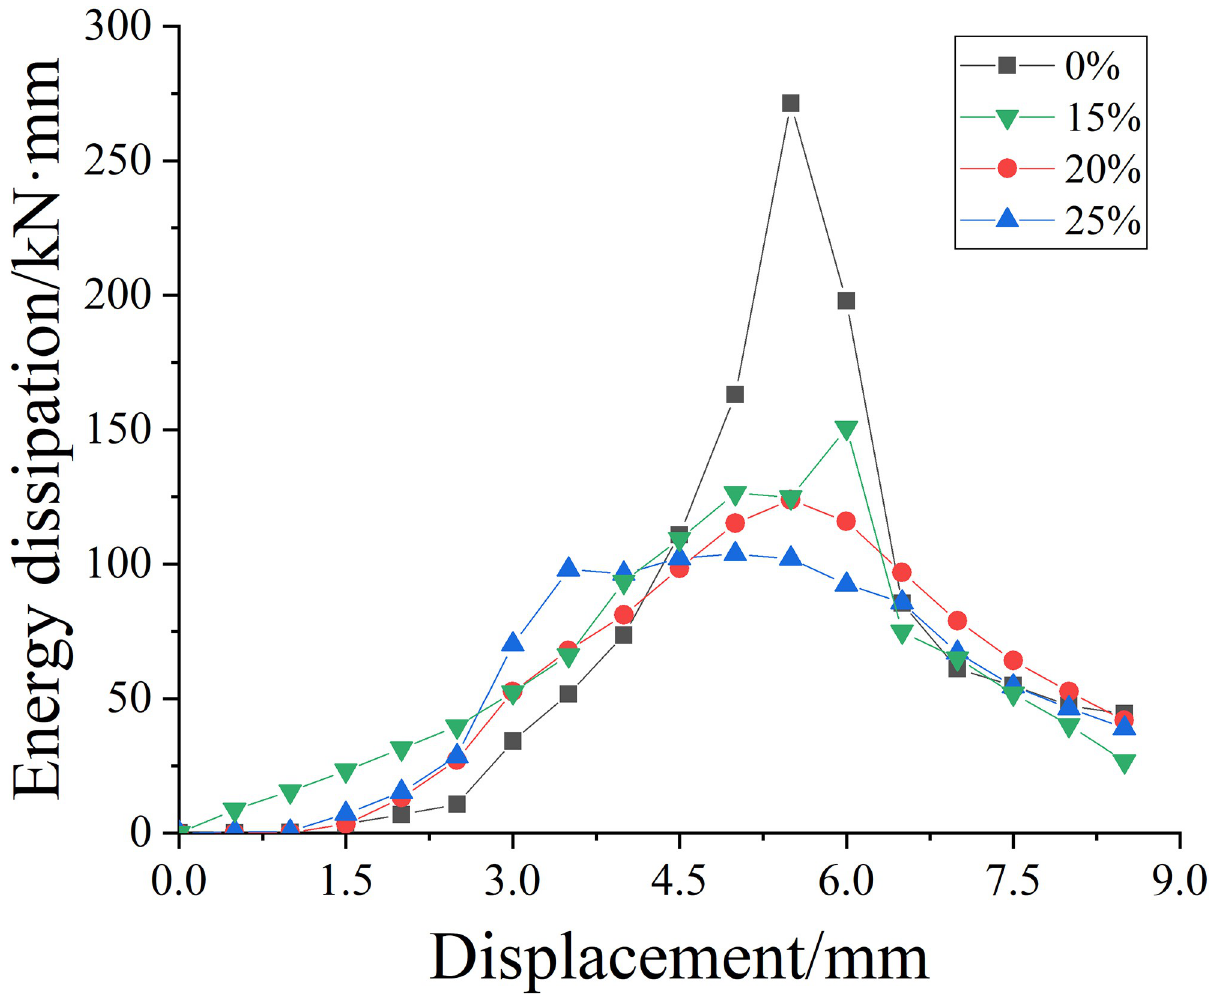
Fig 10. Energy dissipation displacement curves of specimens with different concentrations of salt solution.